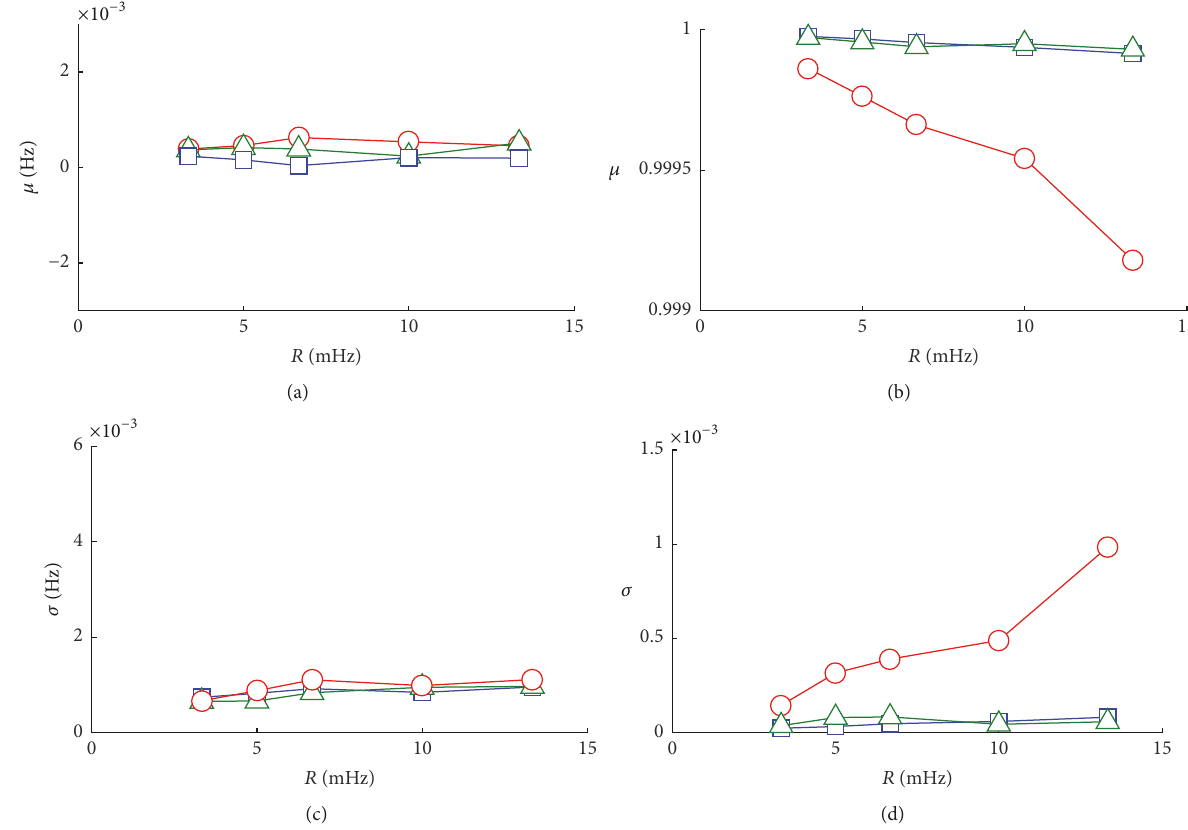
Figure 3: Results of the MCMC simulations for pLSCF as function of R ( 𝑁 = 36 ): mean value of the error for the eigenfrequency estimation (a), mean value of the MAC (b), 𝜎 of the error for the eigenfrequency estimation (c), and 𝜎 for the MAC (d). Curves with squares ( ◻ ) for the first mode, with circles ( I ) for the second mode, and with triangles ( 󳵻 ) for the third mode.